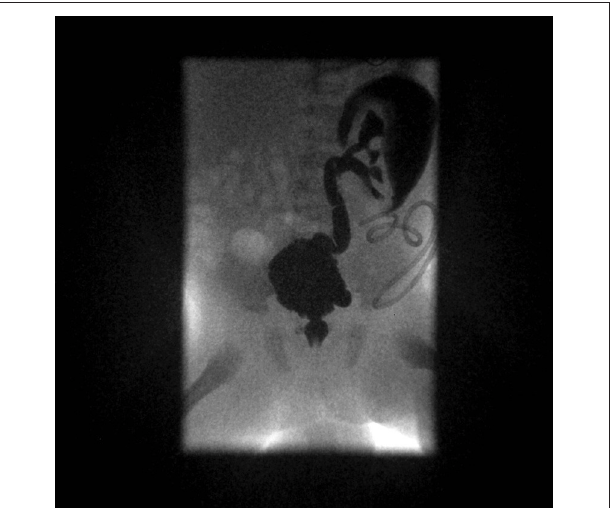
FIGURE 5 | High-grade RVU and megabladder with diverticula in a child with posterior urethral